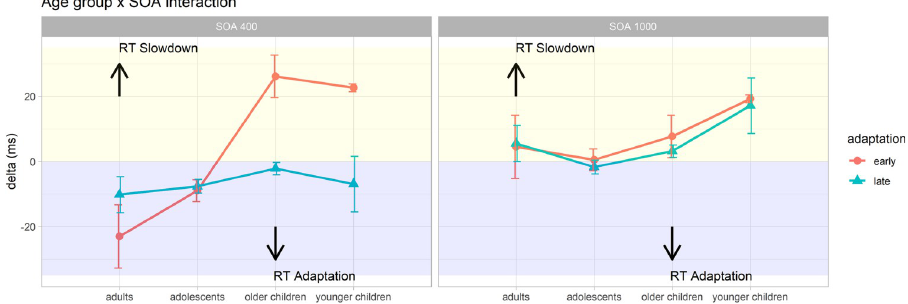
Fig 3. Early and late behavioral adaptation. The panels represent the developmental trajectories of the ability to adapt response speed on global prediction changes relatively to the early (block 2 minus block 1; red line) and late (block 4 minus block 3; light blue line) stages of the task and separately for short and long preparatory intervals (SOA). The left panel (short SOA) shows negative delta scores (RT adaptation; violet half) only for adolescents and adults and positive delta scores for (RT slowdown; yellow half) children. Conversely, all participants exhibit RT slowdown with an increased preparatory interval (long SOA). Error bars represent standard error ( SE ).